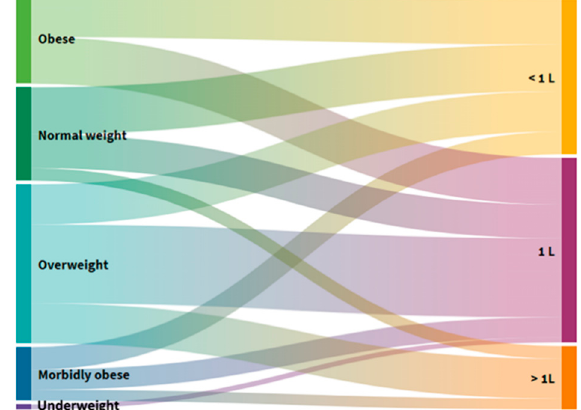
Figure 7. Alluvial diagram of the distribution of users by BMI groups and fluid intake.